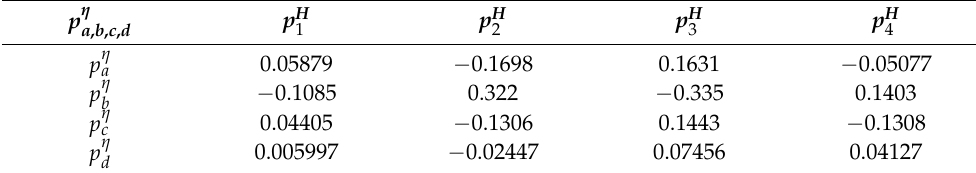
Table A4. Coefficients of the fitting model for Beidou system (Mean orbital height (MEO): 21,550 km).